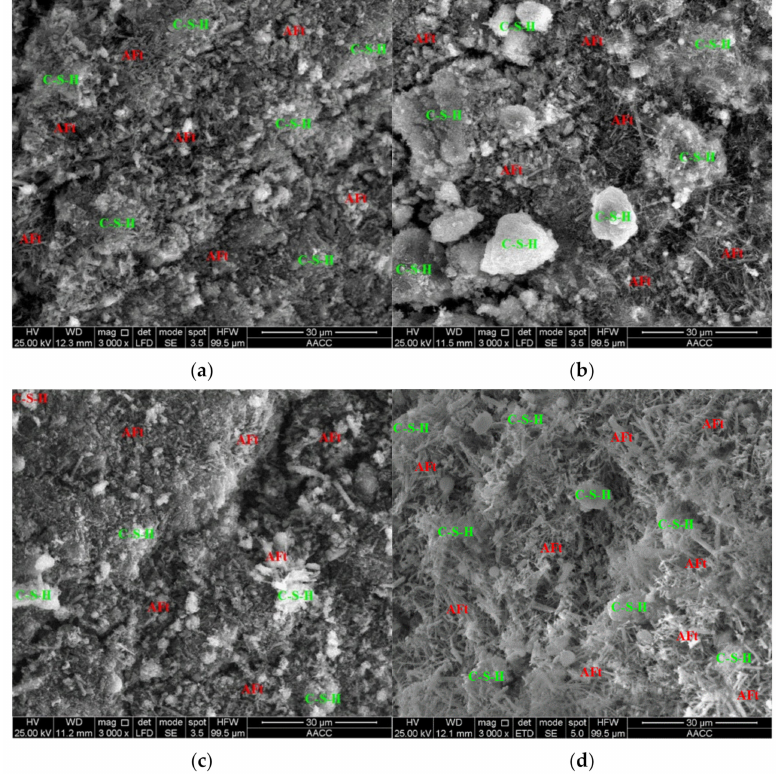
Figure 9. The morphologies with different mixtures: ( a ) W2L1-7d; ( b ) W2L3-7d; ( c ) W3L1-7d; ( d )